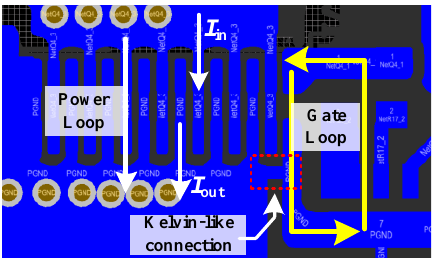
Figure 6. PCB layout for driving loop of GaN HEMT.